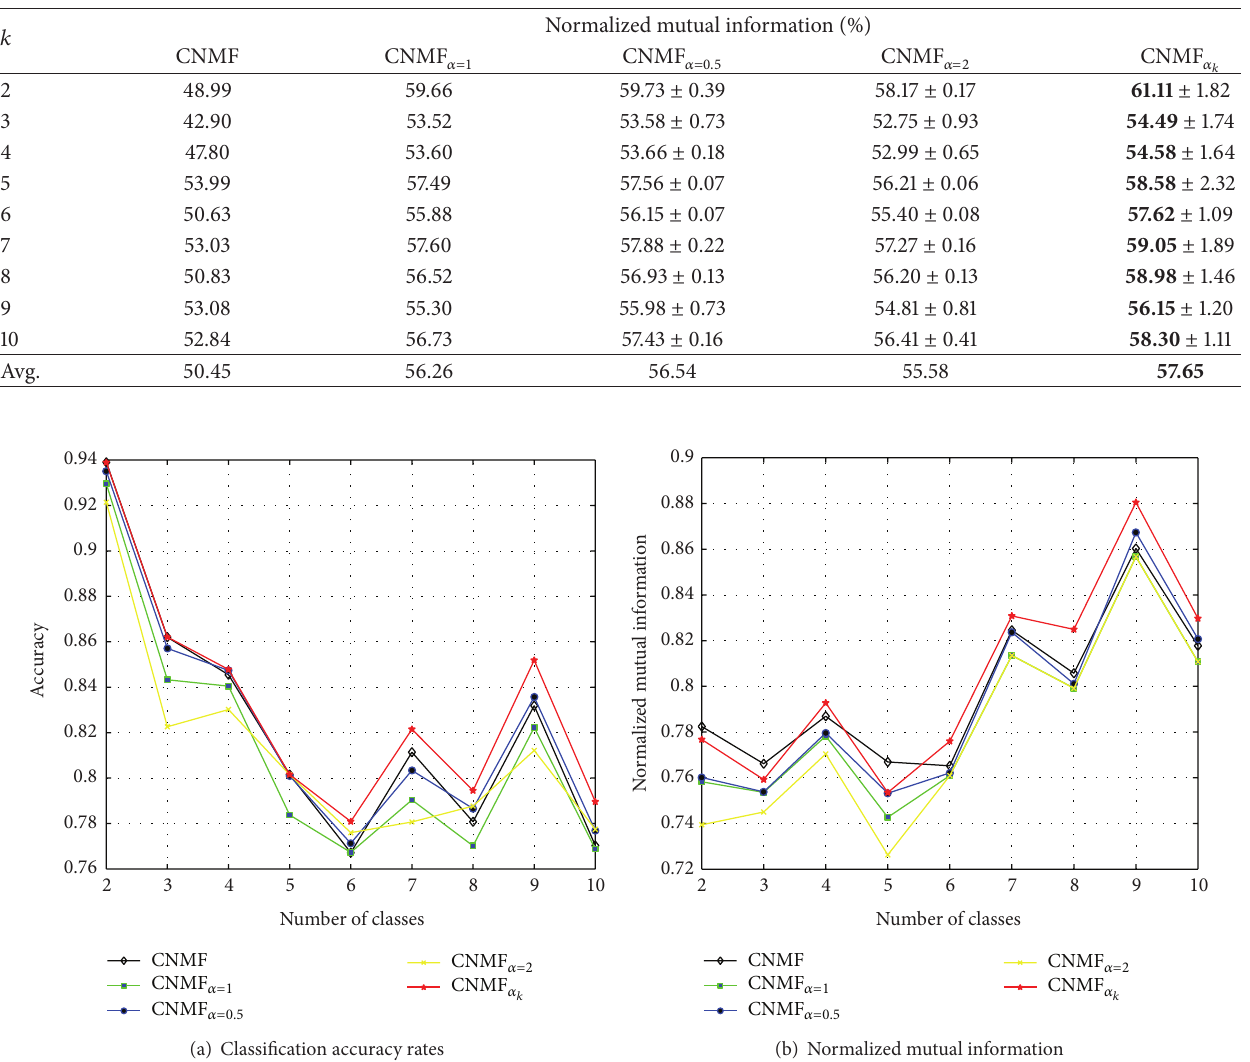
Table 4: The comparison of normalized mutual information on the Yale Database.